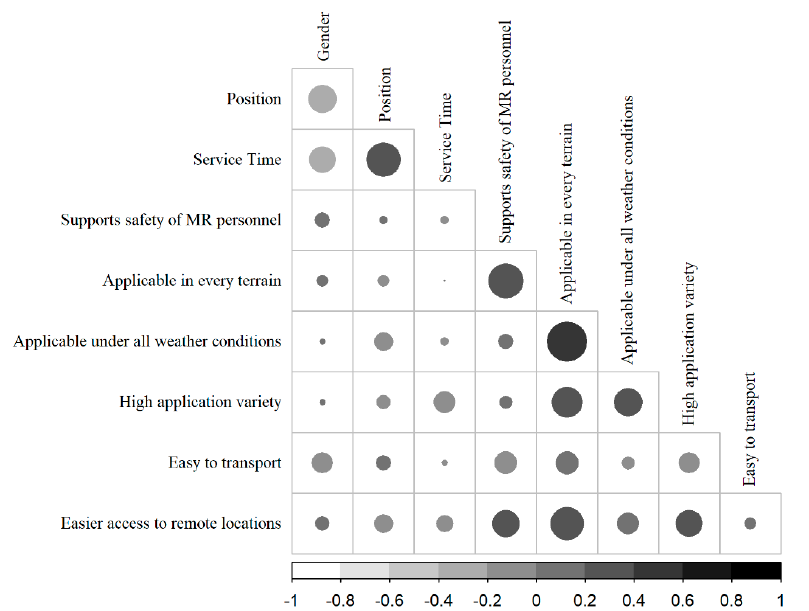
Figure 4. Correlation matrix of most important attributes and participant characteristics.